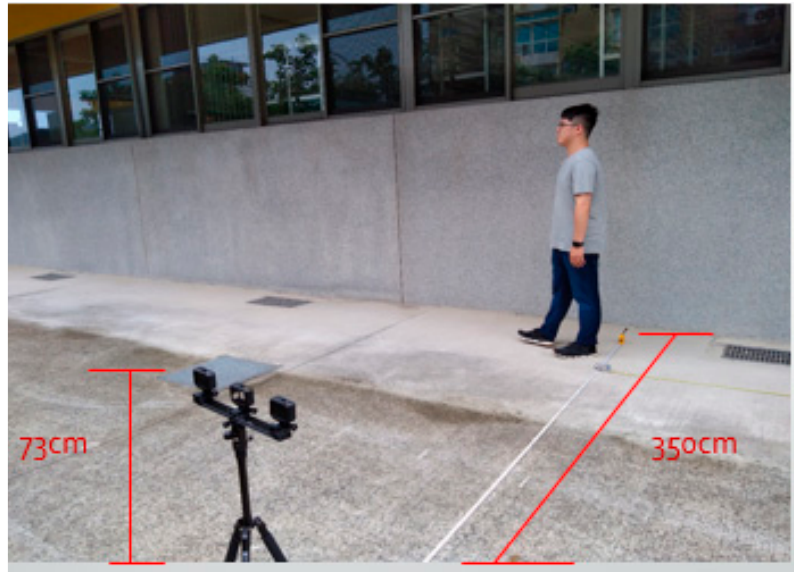
Figure 3. Experimental architecture diagram.